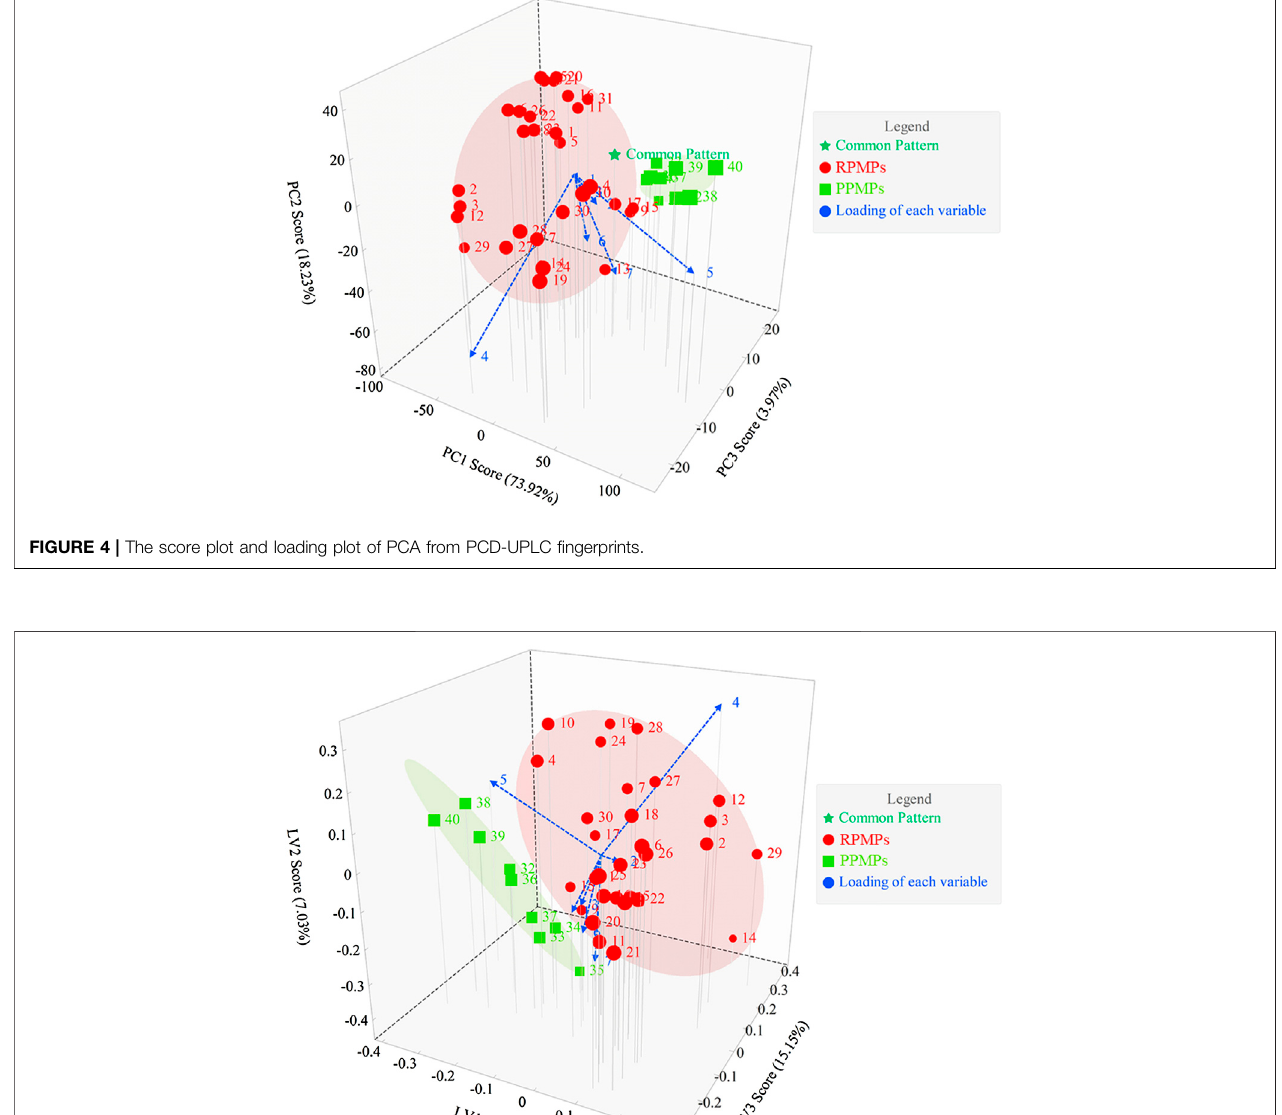
Frontiers in Pharmacology |